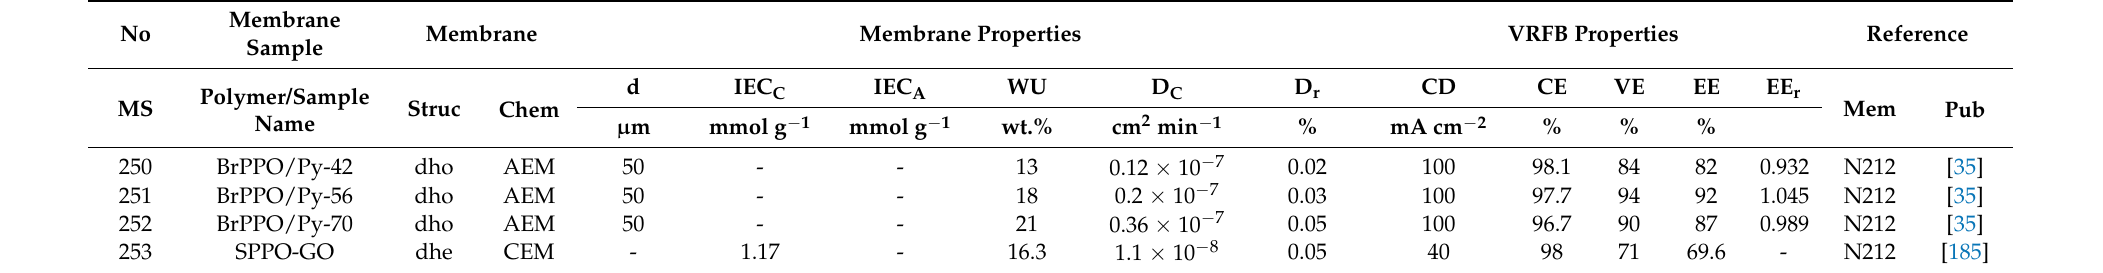
Table 10. List of poly(phenylene ether)-based hydro-carbon membrane samples.